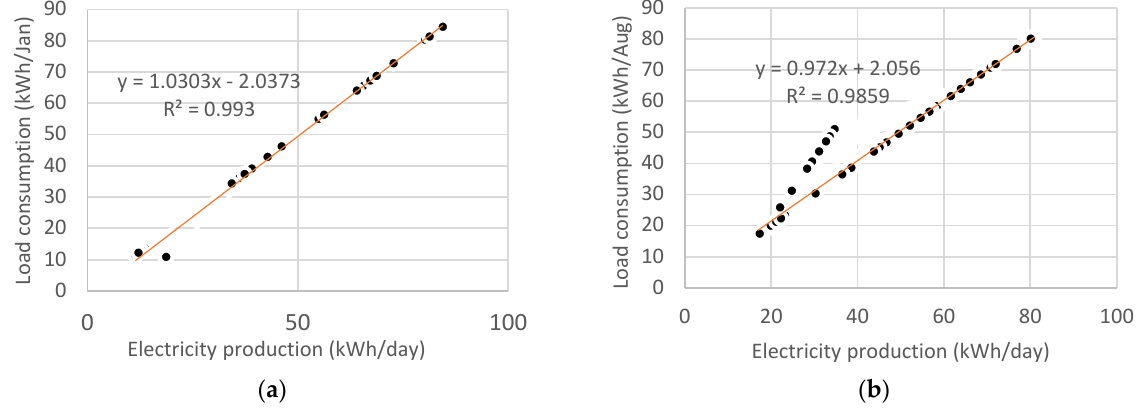
Figure 11. The monthly average power consumption and production correlation, January ( a ) and